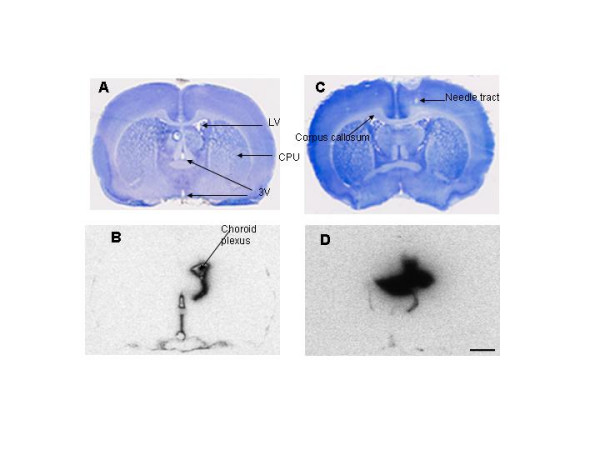
Nissl-stained histologies (A and C) and adjacent autoradiograms (ARG's; B and D) showing the lateral (LV) and the third (3 V) ventricles 30 min after injection into one lateral ventricle (A and B, respectively) or into the parenchyma (C and D, respectively). 1A. This histological section is at bregma -0.2 mm and cuts through the cerebral cortex (not labeled), LV, caudate-putamen (CPU), 3 V, anterior commissure (not labeled), and the optic chiasm (missing on the histology, but evident on the ARG, 1B). 1B. The lateral ventricle choroid plexus and the walls of the LV and 3 V on the ipsilateral side are darkly labeled on this ARG, but little radioactivity is evident in the ventricles. The flattened loop of moderate darkness at the very bottom of the ARG demarcates the subarachnoid space around the optic chiasm. The dark half-ring or crescent above the optic chiasm partially surrounds the medial nucleus of the preoptic area, a peculiar pre-hypothalamic structure; this crescent appears to be an extension of the ventral part of the 3 V but may be an artifact. 1C. This section is at bregma -0.3 mm and passes through the same structures as 1A above. Notable on this histology are the needle tract and corpus callosum, which on the ipsilateral side below the tract is expanded, pale, and edematous. 1D. Most of the radioactivity in this ARG is contained in the tissue near the main site of the intraparenchymal infusion, but some is in the choroid plexus and CSF (both shown by the tail below the main patch of blackness on the ARG). Much of the tissue radioactivity is in the corpus callosum and some of it extends via this white matter tract across the midline. Scale bar = 1.5 mm.